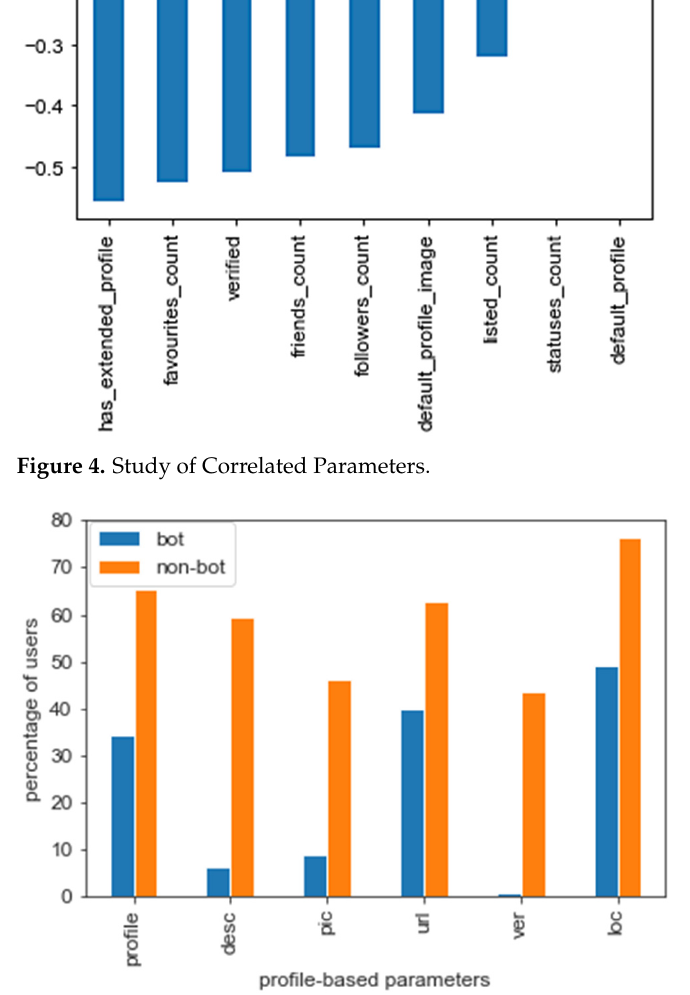
Figure 5. User Quantity based on profile parameters .